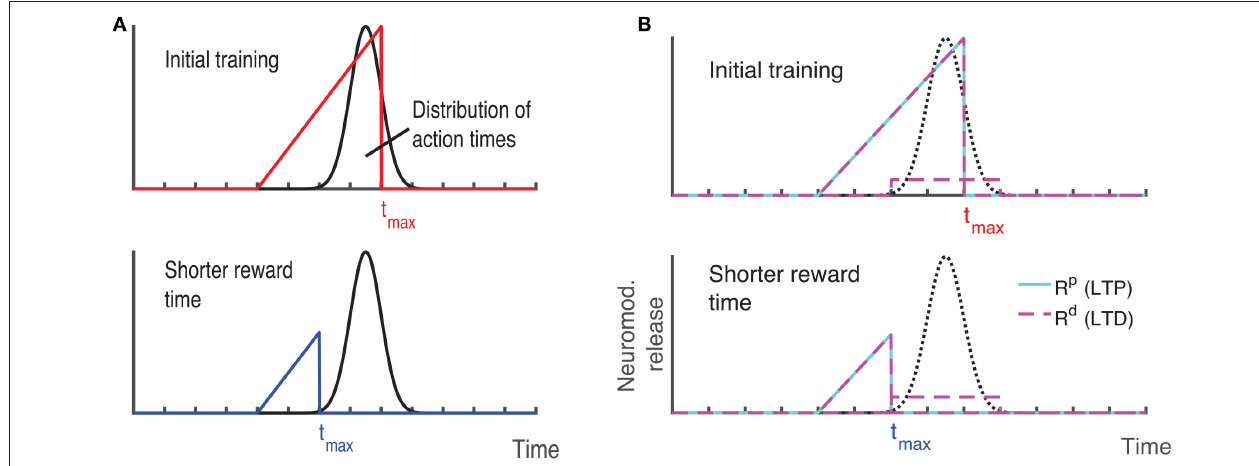
FIGURE 3 | Ramp reward paradigm and neuromodulator release profile. (A) Single neuromodulator case. The reward magnitude as a function of response time is shown by the red line in the upper panel. The longer the subject waits, the bigger the reward, until a time t max after which no reward is received. It is assumed that the magnitude of the single neuromodulator follows this profile as well. The black curve in the upper panel shows schematically the distribution of response times after learning is complete. In the lower panel a situation in which the maximum reward time ( t max ) is decreased (blue) while the action time responses have not yet changed in response to the new reward paradigm. Because the actions occur in the unrewarded region, the network cannot learn this new condition. (B) Two neuromodulator case. The reward paradigm is the same as in (A) , but the two neuromodulators respond differently. The two neuromodulator profiles are depicted by different colors as defined in the legend (cyan for LTP and magenta for LTD related traces). For the long reward time (upper panel), both neormodulators have the same profile if there is a reward. However, if there is an action but no reward, only the LTD related neuromodulator is released. This becomes more apparent when the reward time is shifted to a shorter duration (lower panel). Here, most responses are not initially rewarded and only the LTD related neuromodulator is released, triggered by the